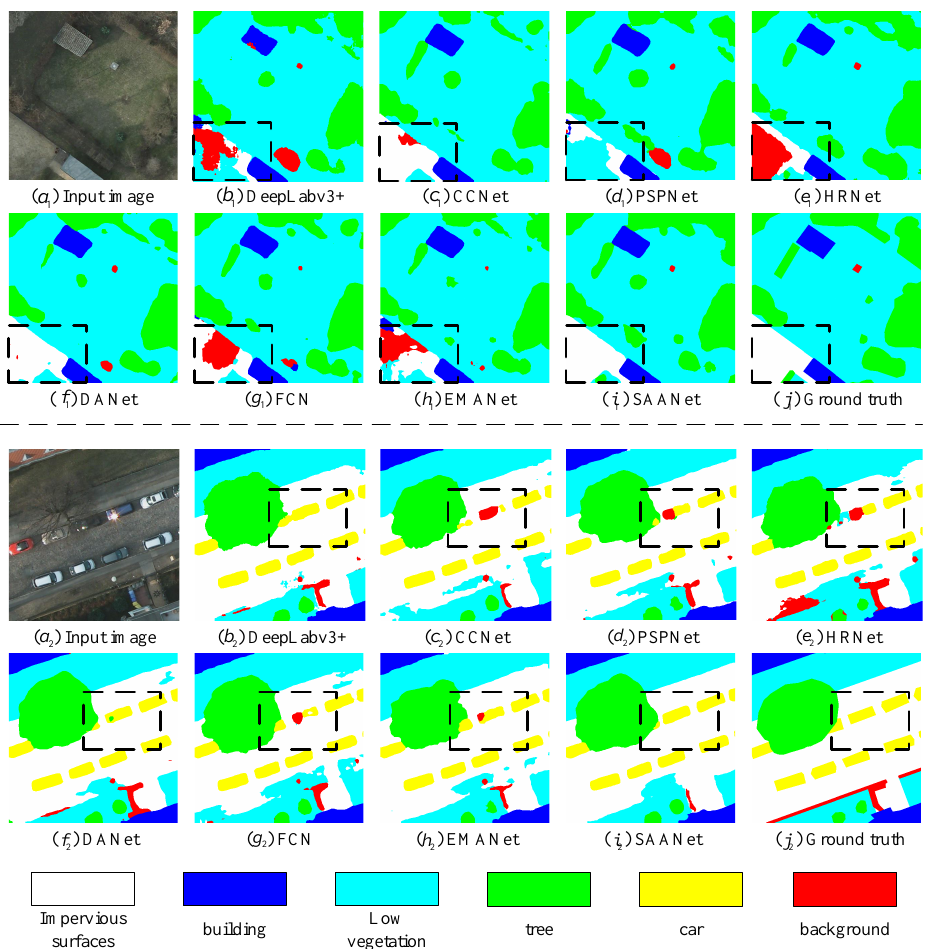
Figure 9. Visual results achieved by different networks on ISPRS Potsdam dataset. For the first group, other methods incorrectly predict pixels inside impervious surfaces. For the second group, several pixels representing cars are incorrectly predicted. However, our SAANet can maintain category consistency and obtain more accurate pixel